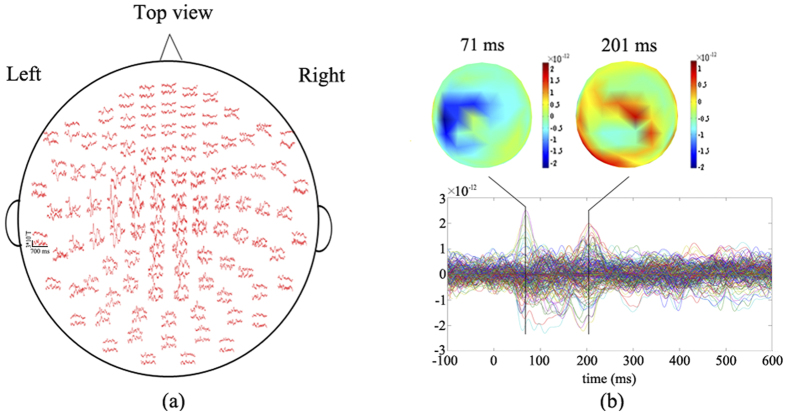
(a) Spatial distribution of MEG averaged responses. At each sensor location, the traces illustrate signals recorded by two orthogonal gradiometers. (b) Group averaged waveforms from each channel are plotted in different colors and superimposed and scalp topographies at 71 ms and 201 ms peak latencies are displayed.